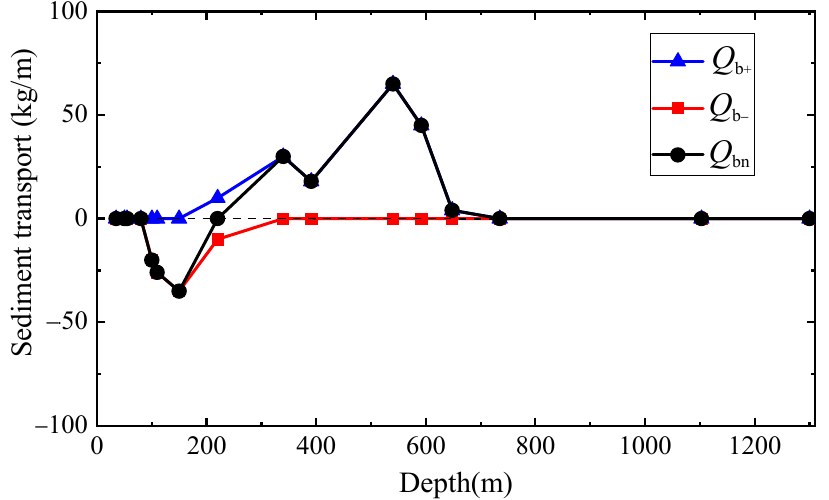
Figure 12. Net mass transport per unit width in one week vs. water depth.